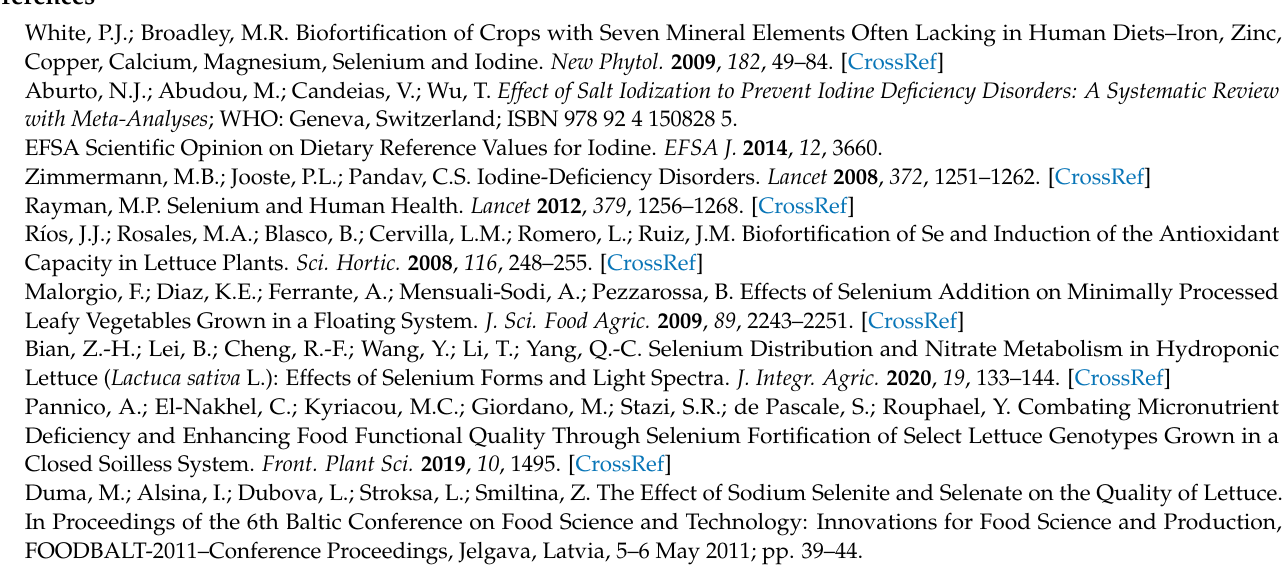
Table S16. Weight loss during post-harvest: results of four-way ANOVA with hydroponic system (HS), selenium (Se), idione (I) and time during post-harvest